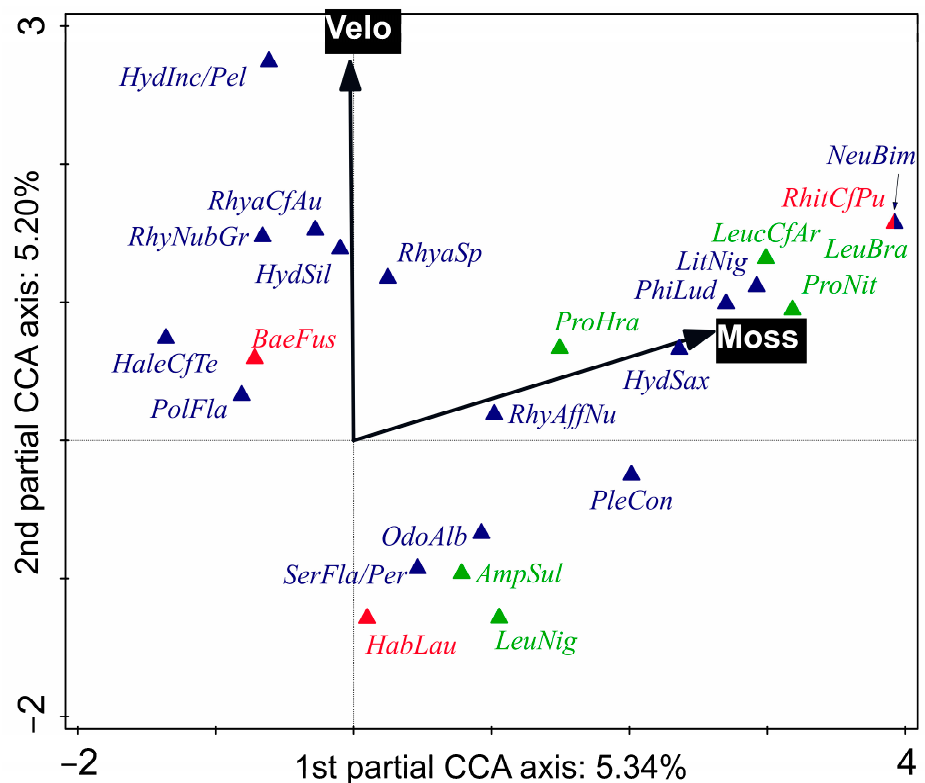
Figure 4. Species + subplot environmental variables (EVs) biplot: the first 24 best-fitting species are shown (Ephemeroptera, Plecoptera, and Trichoptera labelled in red, green, and blue, respectively). A partial Canonical correspondence analysis (CCA) was used. Ordination axes were constrained by the EVs selected by forward selection, which accounted for 10.54% of the explained variation. Test